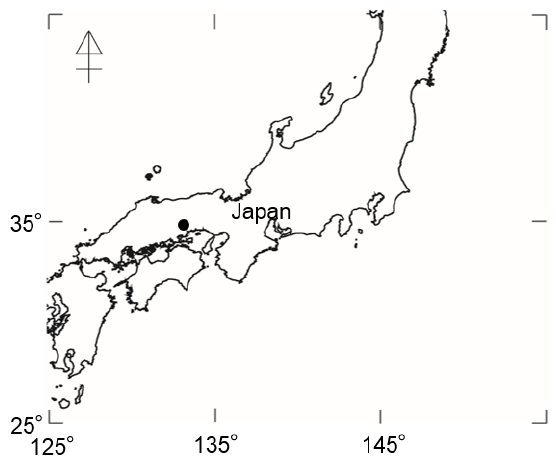
Figure 1. A location map of study area (indicated by a black